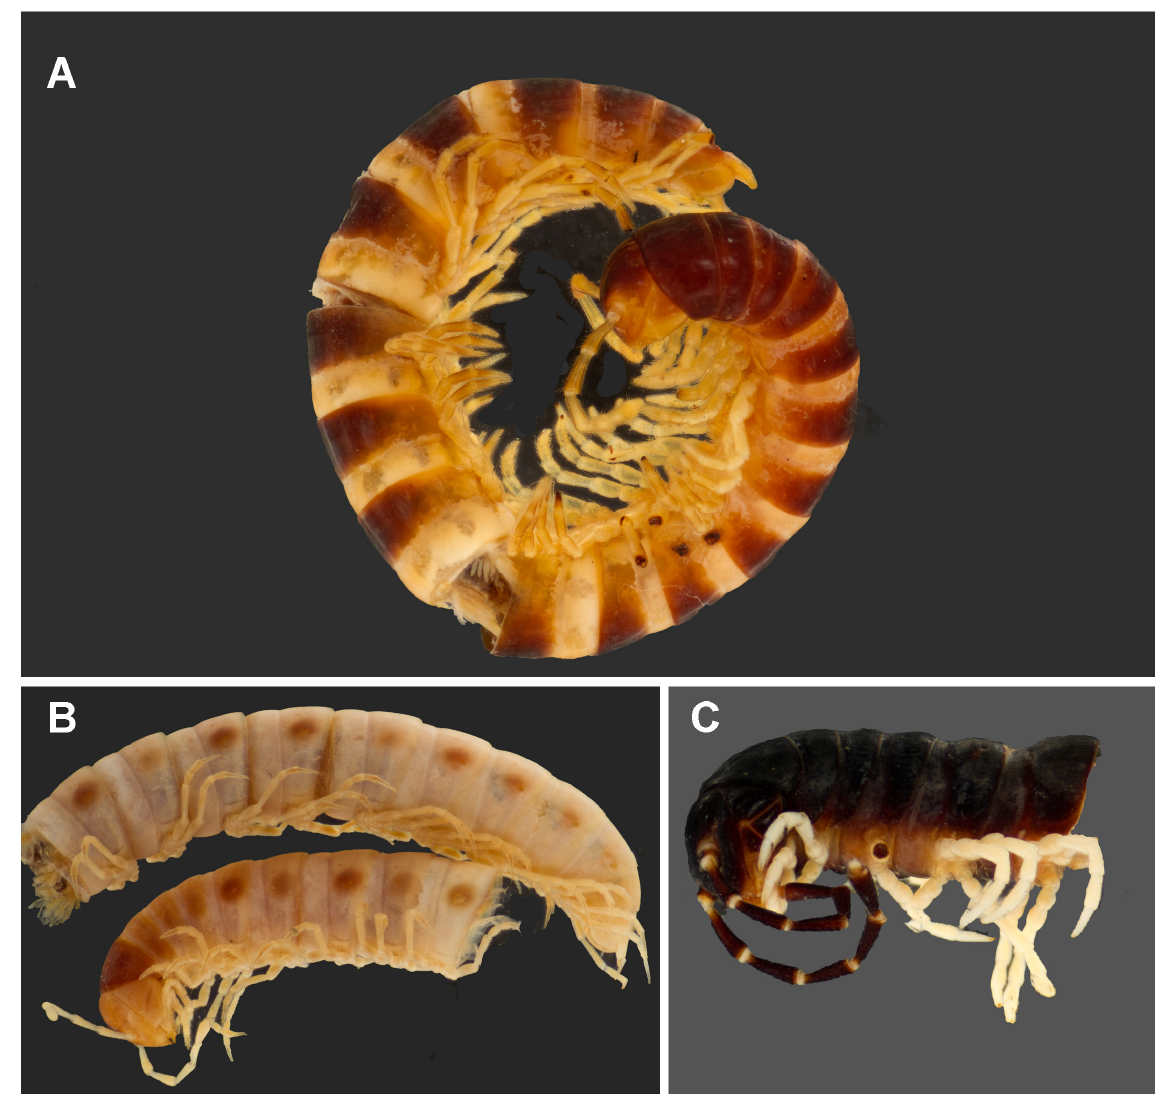
Fig. 3. Eviulisoma spp., examples of colour patterns. A . E. akkariae sp. nov., paratype, showing a banded pattern (pale prozonites, dark metazonites) similar to that shown in Fig. 1. B . E. coxale sp. nov., tentatively referred female from type locality, showing dark lateral spots on a pale background. C . E. biquintum sp. nov., paratype from Mito Mitatu, showing a black body contrasting with white legs. Not to scale. Photographs by F. Vad and A.